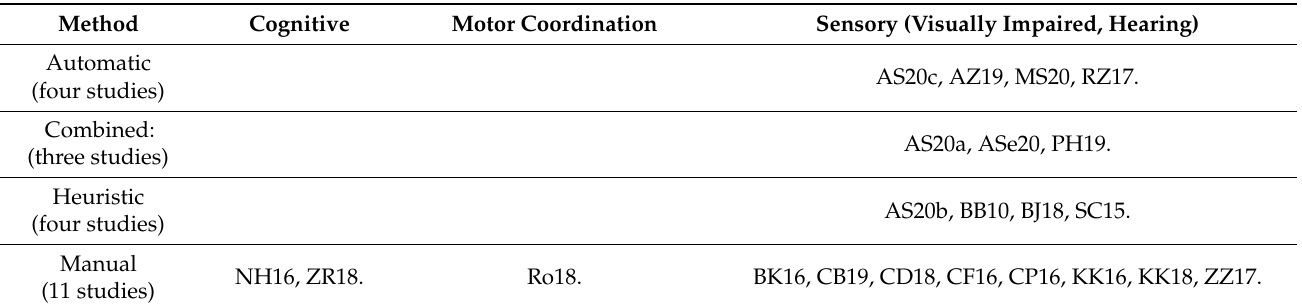
Table 6. Evaluation methods applied by